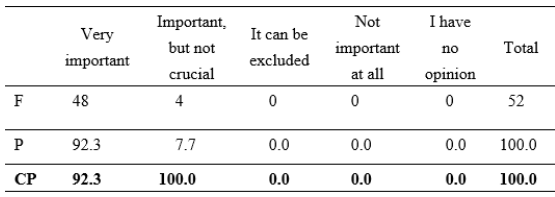
Table 12. Student’s attitudes about